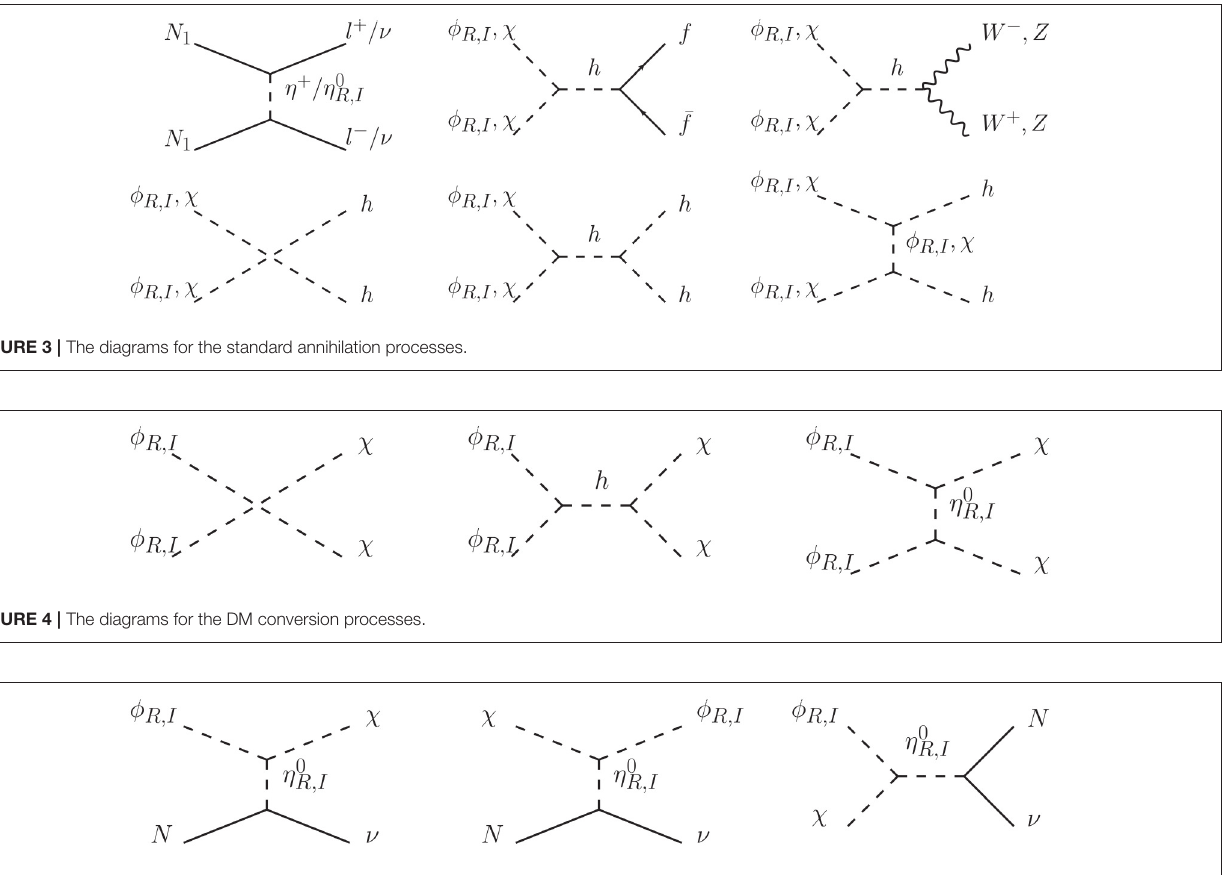
FIGURE 5 | The diagrams for semi-annihilation